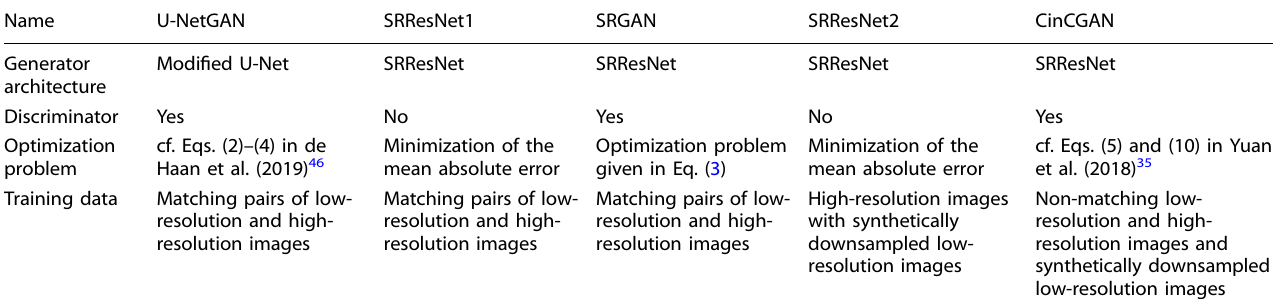
Table 1. Overview of the training speci fi cations for the neural networks considered in the present